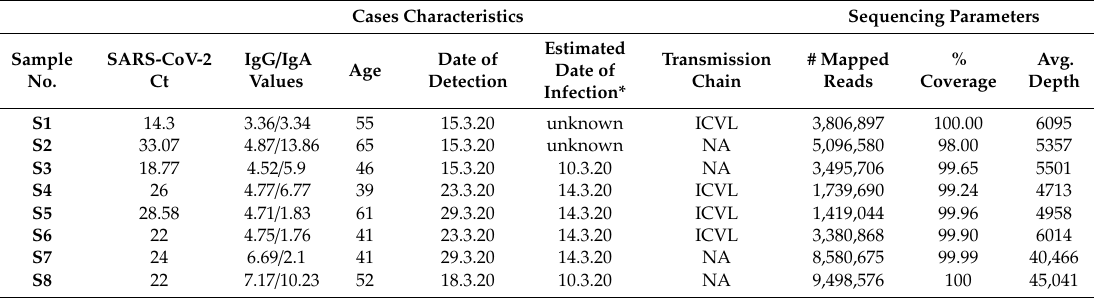
Table 2. Infected cases characteristics and sequencing